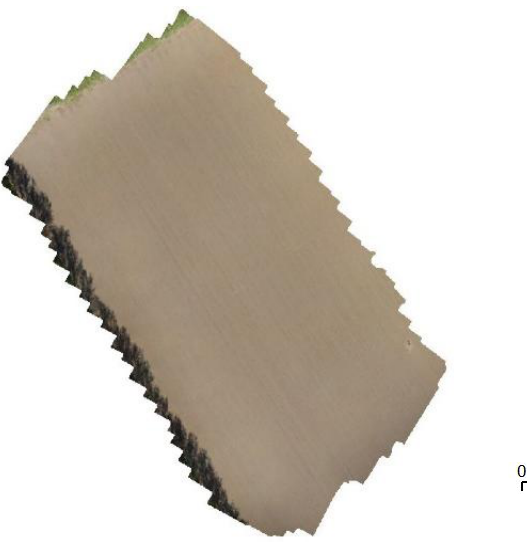
Figure 2. Color (RGB) orthophoto of bare soil, computed